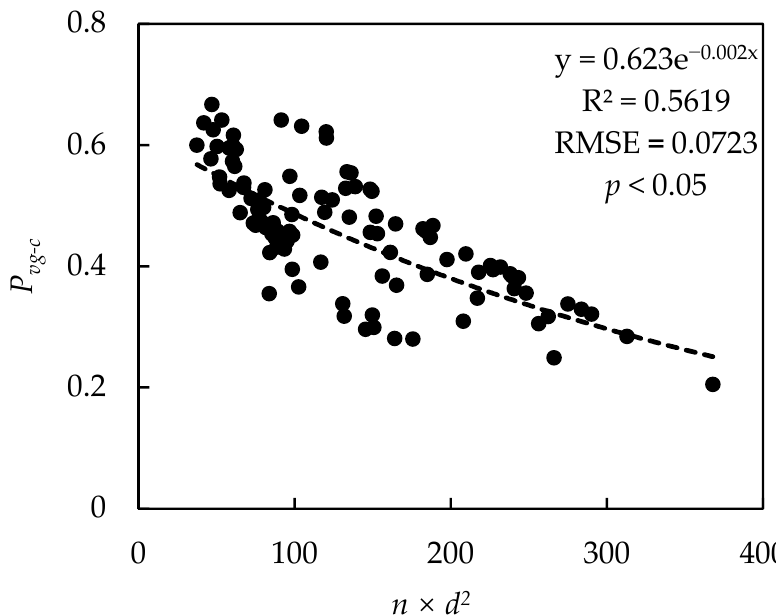
Figure 4. Scattering plot between P vg-c and n × d 2 . The relationship between n × d 2 and the P vg can be seen in Figure 5. The coefficient of determination and the RMSE of the canopy closure estimation model were 0.3138 and 0.0813, respectively. Compared to the model established with the P vg-c , these results do not seem to be as good as the results above. This is because the gap between the canopy was represented by the P vg in the GOST model. Additionally, n × d 2 represented the projections of the canopy without considering the gaps in the canopy. Therefore, the linear relationship between these two variables was weakened. At the same time, the results that were estimated using this model underestimate the canopy due to the gaps in the canopy represented by the P vg .